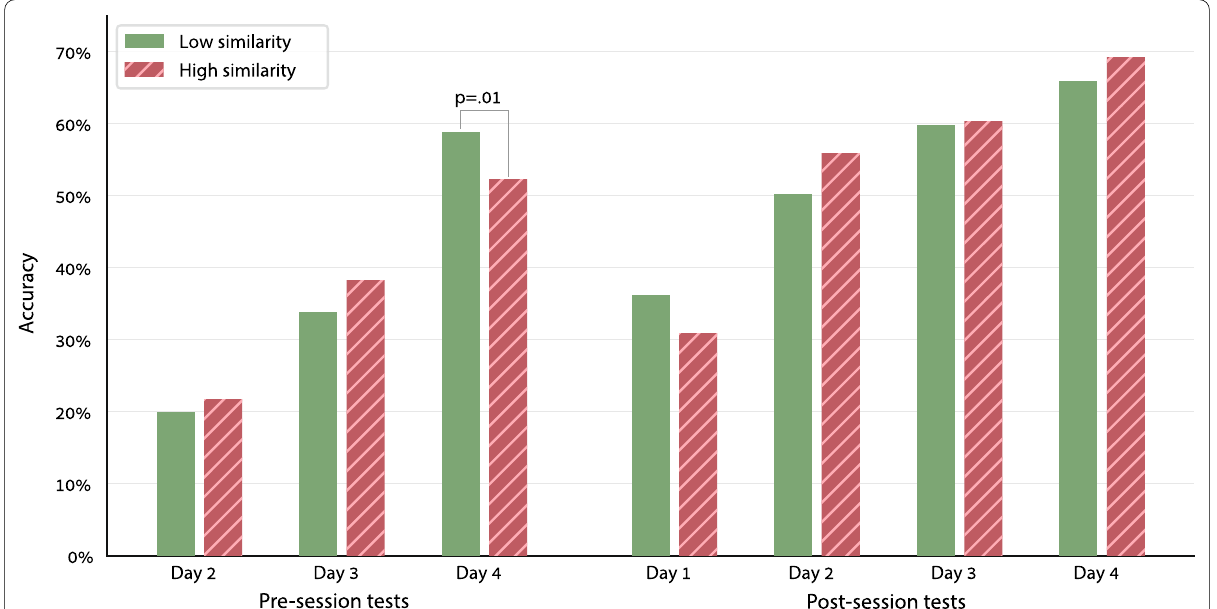
Fig. 3 Accuracy in the short tests conducted at the beginning and end of each training session. The overall performance improves from day to day. Critically, a similarity effect was observed only in the pre‑session test of the last training day—the test that was most sensitive to long‑term memory representations. In all other pre‑ and post‑session tests, the similarity effect was not